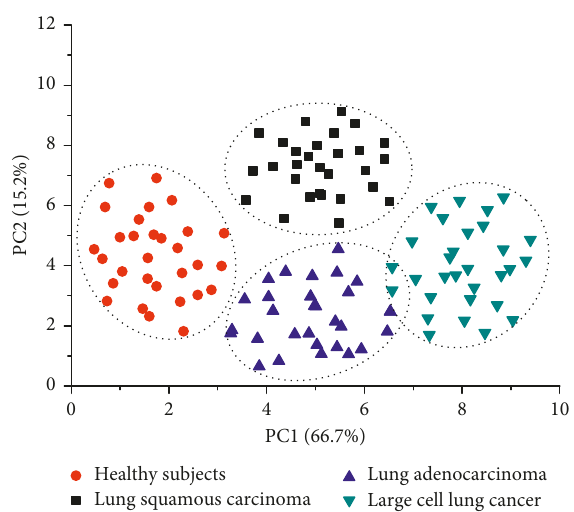
Figure 8: PCA score plots of SERS spectra for serum obtained from large cell lung cancer patients, lung squamous carcinoma patients, lung adenocarcinoma patients, and healthy subjects. Each type of NSCLC was coded with a different